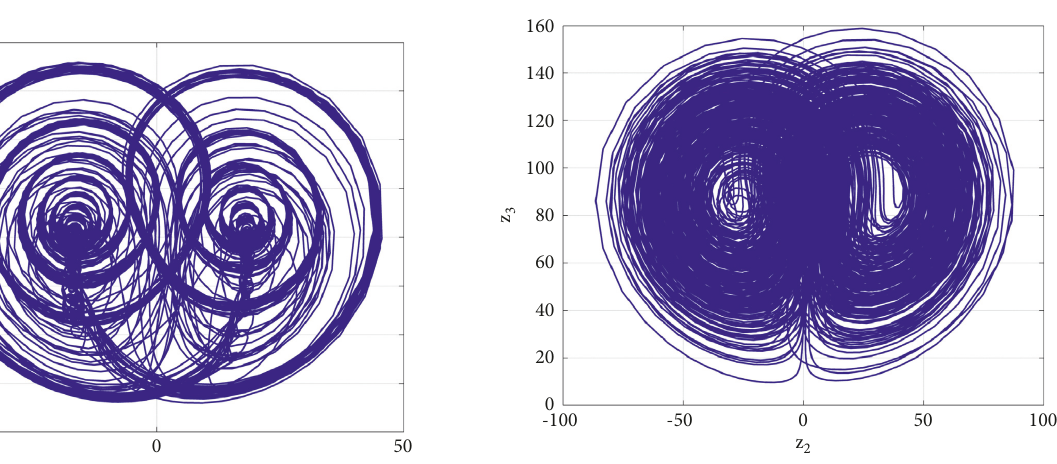
Figure 19: A hyperchaotic attractor of the model (1) for c � 90 and ( a, b,d ) � ( 25 , 8 , 6 )